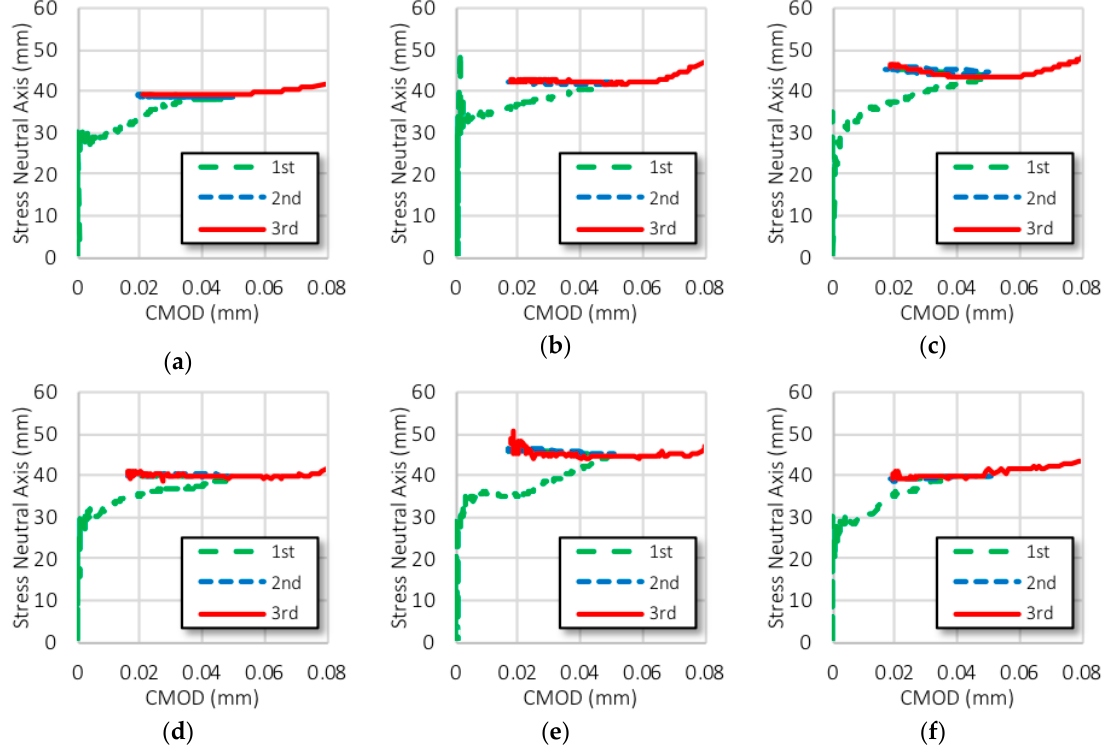
Figure 18. Typical stress neutral axis-CMOD curves for different healing periods. ( a ) 7-28W; ( b ) 7-49W; ( c ) 7-70W; ( d ) 7-28A; ( e ) 7-49A; ( f ) 7-70A.